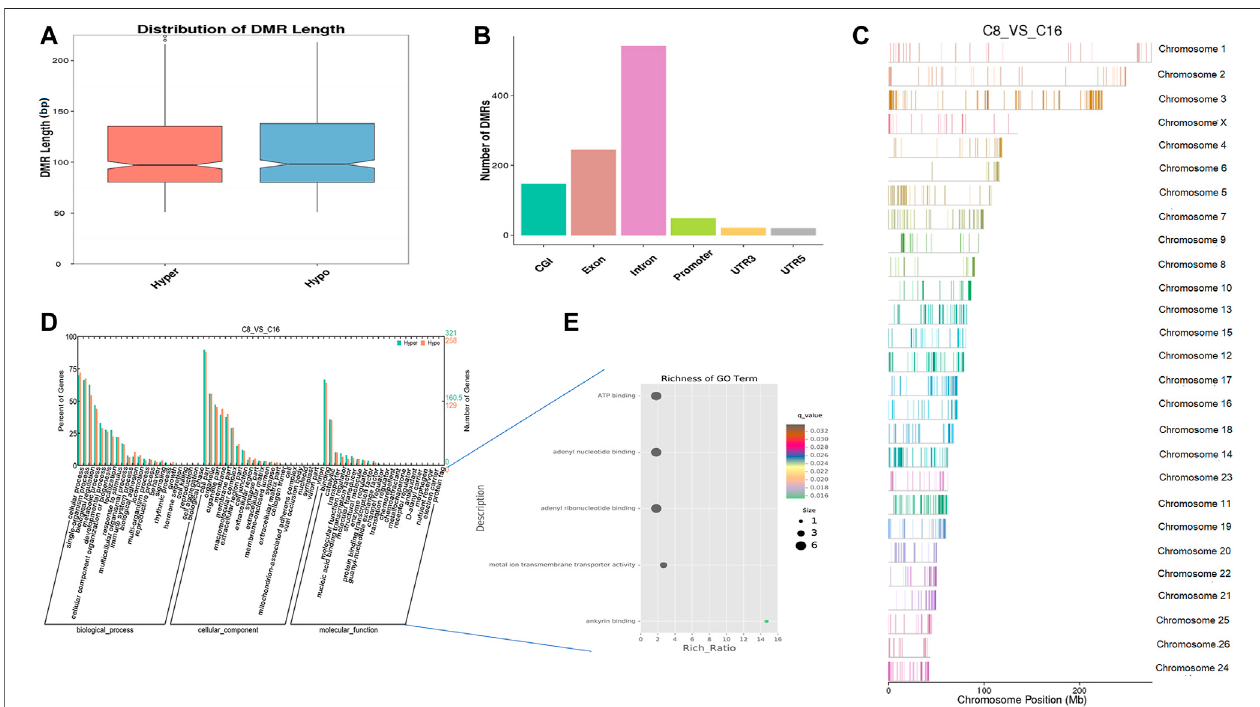
FIGURE 4 | Differentially methylated analysis from the 8 to the 16-cell stage. (A – C) DMR length, functional annotation, and distribution in chromosomes at these stages. The length of DMRs: the horizontal axis represents the methylation status of the DMRs, Hyper is relatively hypermethylated, Hypo is relatively hypomethylated, and the vertical axis represents the length of the DMRs (A) . The functional annotation of DMRs: the horizontal axis represents different genomic functional regions, promoters,exons,etc.;theverticalaxisrepresentsthenumberofDMRsannotatedtoaparticularfunctionalregion (B) .ThelocationofDMRsinthesheepgenome: the horizontal axis represents the chromosomal location, the vertical axis represents the chromosome (C) . (D, E) GO enrichment analysis. Based on the structural annotation results of DMRs on the genome, functional enrichment analysis was performed for genes where the DMR overlapped with the promoter and the gene body. The abscissa is each major class under GO terms, the left ordinate is the proportion of the class, and the right ordinate is the speci fi c number of genes in the class. Different colors represent different groups (D) . The signi fi cantly enriched GO term was screened for scatter plot display. The size of each dot indicates the number of differential methylated genes contained in the term, and the color of the dots corresponds to a different q -value. Rich Ratio refers to the ratio between the number of differentially methylated genes enriched in the GO term and the background number. The larger the Rich Ratio, the greater the degree of enrichment. The q -value is the adjusted p -value after multiple hypothesis testing. The q -value is (0,1). The smaller the q -value, the more signi fi cant the enrichment (E)